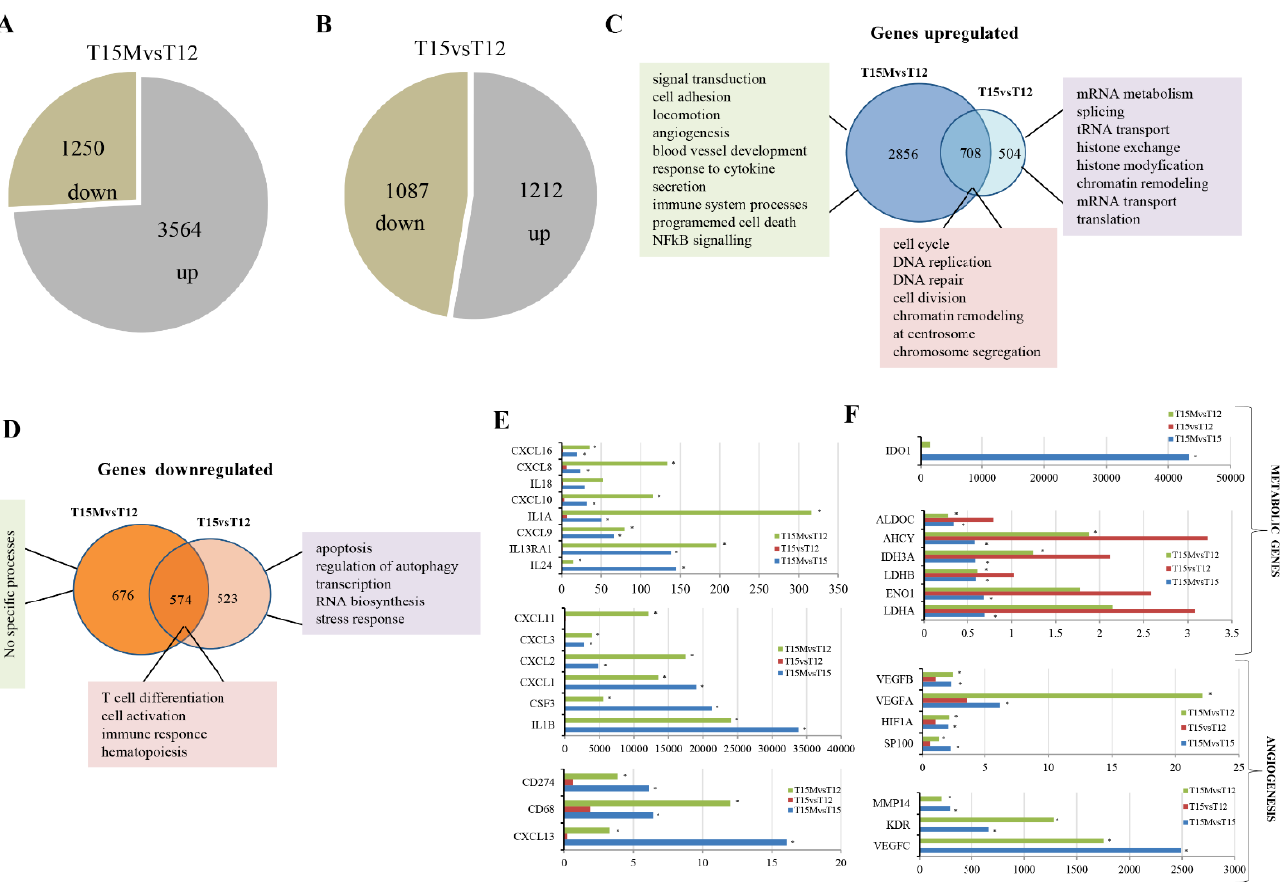
Figure 2. Cancer cells influence CD4 + T cell transcriptomes. The global transcriptomic analysis of differentially transcribed genes performed for ( A ) T15M versus T12 and ( B ) T15 versus T12. ( C ) Gene ontology analysis of genes upregulated in CD4 + T cells restimulated and grown with or without MDA-MB-231 breast cancer cells. ( D ) Gene ontology analysis of the genes downregulated in CD4 + T cells restimulated and grown with and without MDA-MB-231 breast cancer cells. ( E ) The expression of immune-related genes differentially expressed in CD4 + T cells for 12 days after stimulation and 3 days after restimulation with and without cancer cells. ( F ) The expression of metabolism and angiogenesis-related genes differentially expressed in CD4 + T cells on day 12 after stimulation and 3 days after restimulation with and without cancer cells. The fold changes are presented on x axis, while asterisks indicate statistical significance ( p < 0.05).